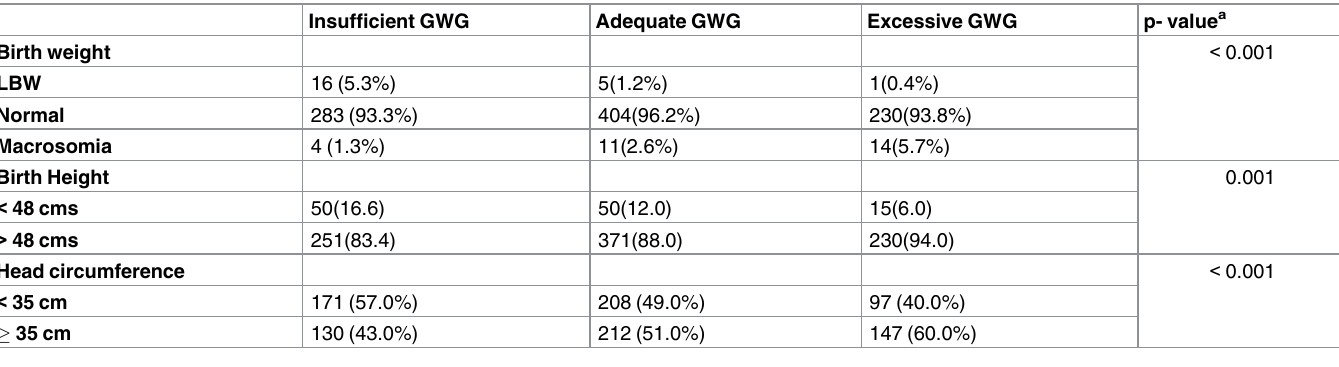
Table 8. Neonatal outcomes by GWG categories.